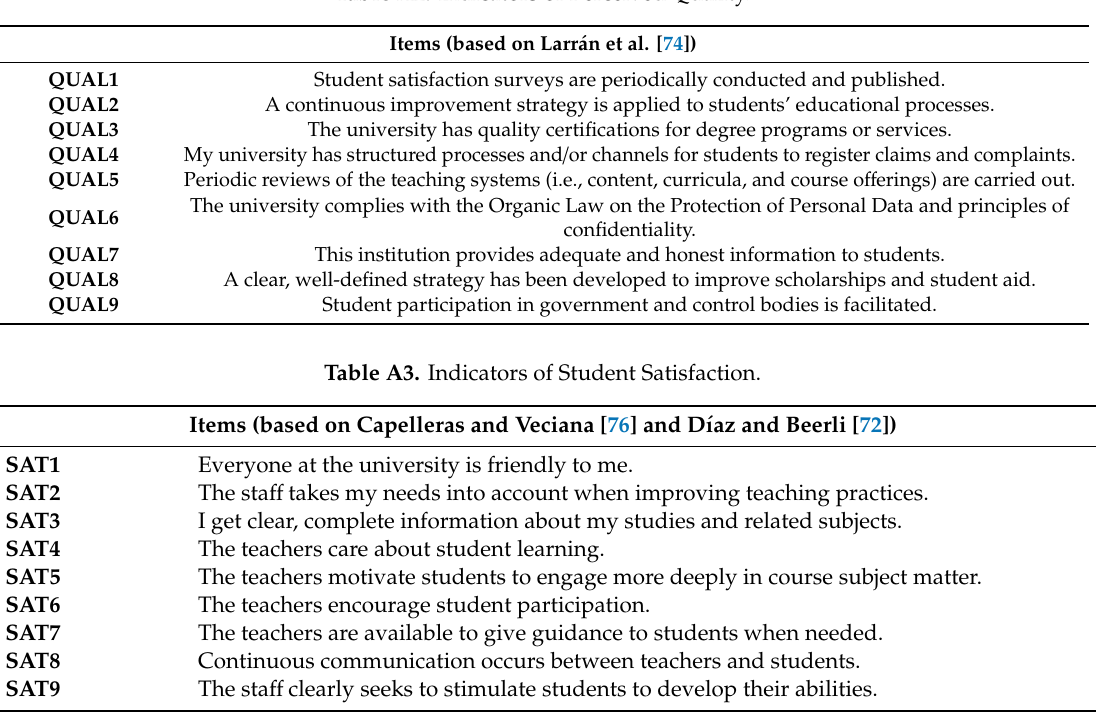
Table A2. Indicators of Perceived Quality.